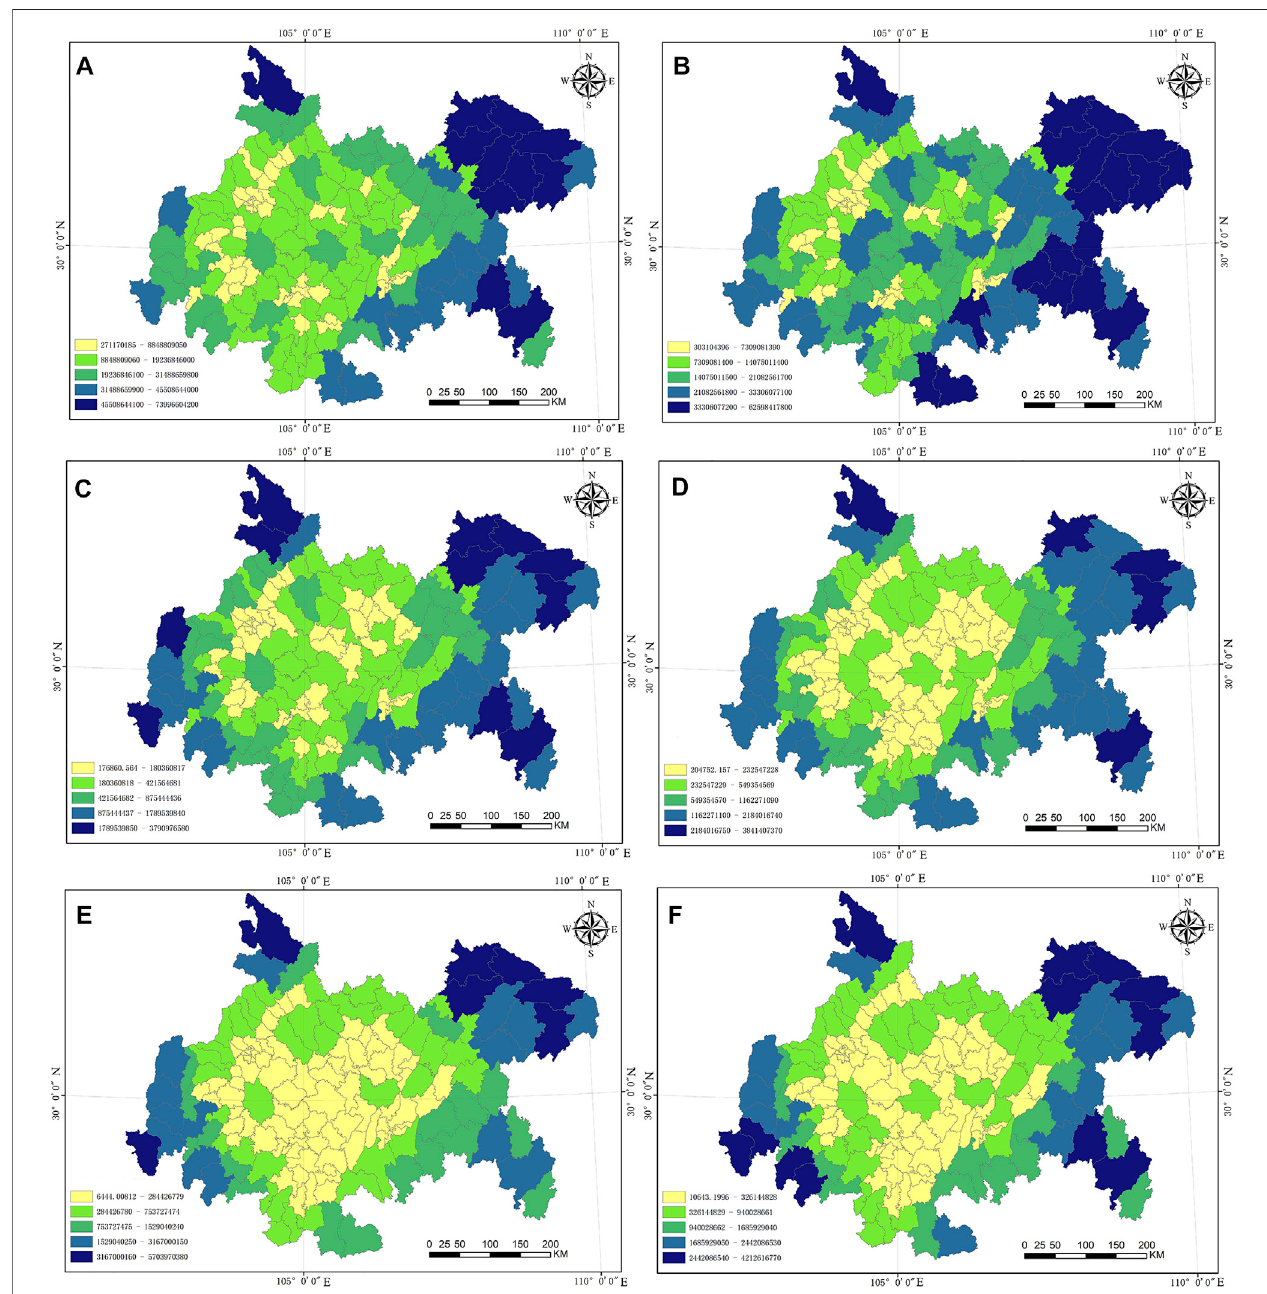
FIGURE 2 | Spatial distribution of ES from 2000 to 2015. (A) 2000 annual water yield (WY); (B) 2015 annual WY; (C) 2000 annual carbon storage (CS); (D) 2015 annual CS; (E) 2000 annual soil conservation (SC); and (F) 2015 annual SC.